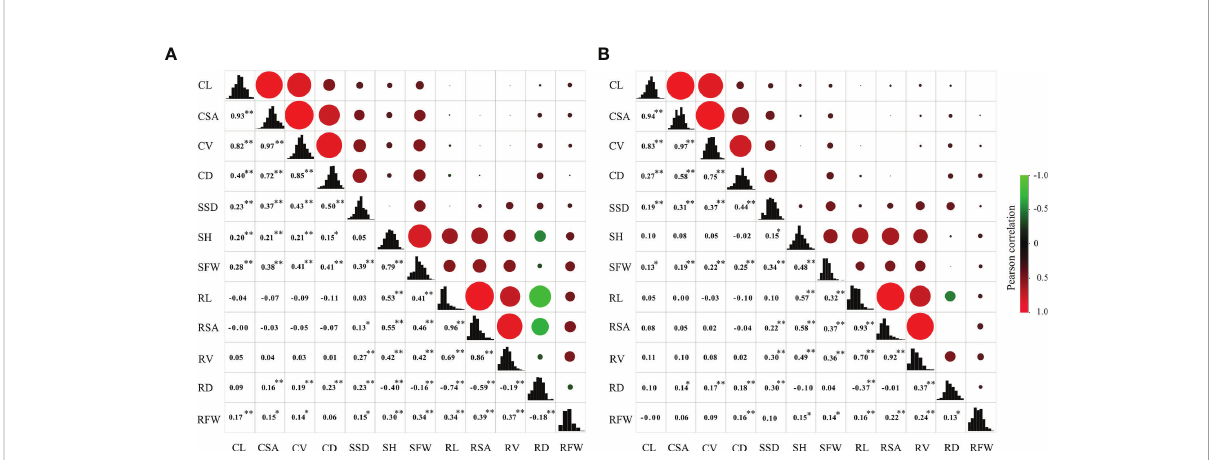
FIGURE 2 Correlation coef fi cients among 12 traits at the germination and bud stages under anaerobic stress in the RIL population. In the upper panel, the size of circle and depth of shading indicate magnitude of correlations. Negative correlations are colored green, and positive correlations are colored red. Lower panel contains correlation coef fi cients, and * and ** represent signi fi cance at 0.05 and 0.01, respectively. The diagonal represents frequency distribution of 12 traits. (A) wet season; (B) dry